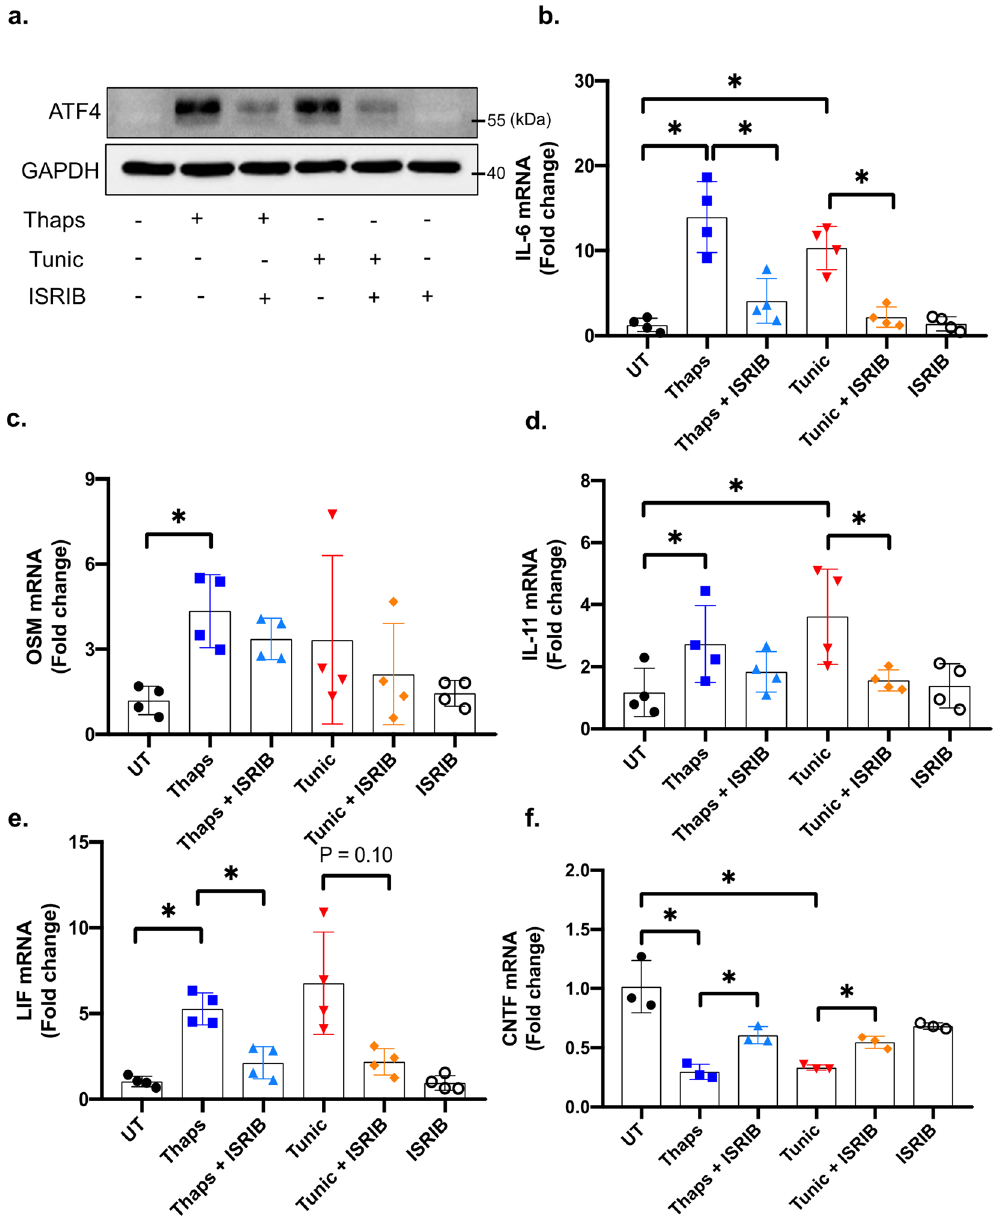
Figure 5. Translational repression regulates the IL-6 cytokine family in astrocytes. ( a ) Primary murine astrocytes were pre-treated with 0.5 μ M ISRIB for 30 minutes prior to ER stress stimulation with 1 μ M thaps or 5 μ M tunic for 4 hours followed by immunoblotting. ( b – f ) Cells were treated as in ( a) , and mRNA expression was analyzed by qPCR. N = 3–4, * P ≤ 0.05. Full-length blots are presented in Supplementary Fig.